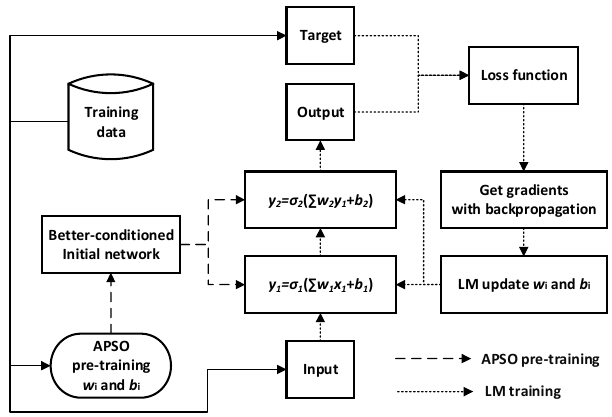
Figure 2. HAPSOLM in artificial neural network (ANN) pre-training and training.